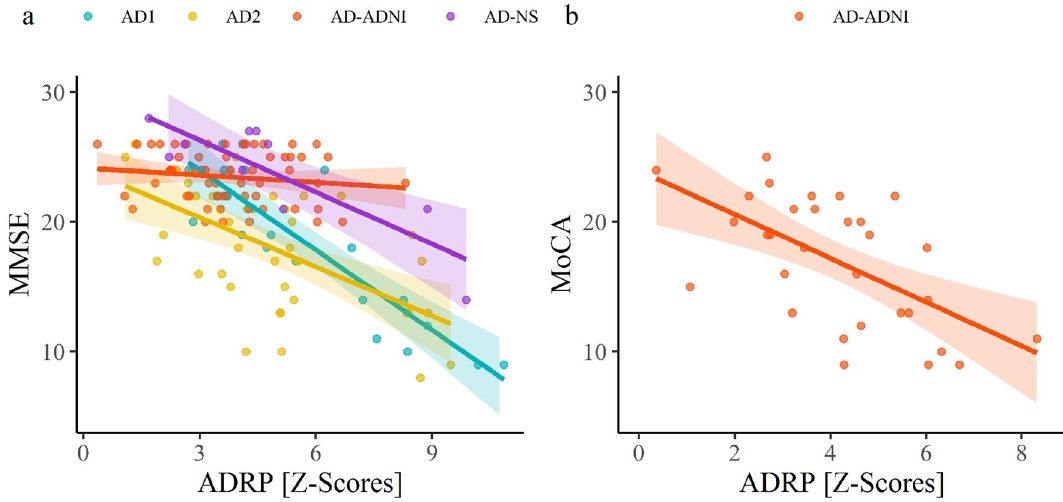
Figure 3. Correlation between MMSE and ADRP expression ( a ) and between MoCA and ADRP expression ( b ). Each dot represents an individual patient’s data and the lines and shaded areas correspond to the fit of a linear regression with 95% confidence intervals. ( a ) ADRP expression correlated with MMSE in AD1 (r = − 0.88), AD2 (r = − 0.58) and AD-NS (r = − 0.85), but not in AD-ADNI (r = − 0.14) group. ( b ) ADRP expression correlated with MoCA in AD-ADNI (r = − 0.60) group. AD1 Alzheimer’s dementia identification group, AD2 Alzheimer’s dementia validation group, ADNI Alzheimer’s Disease Neuroimaging Initiative, NS